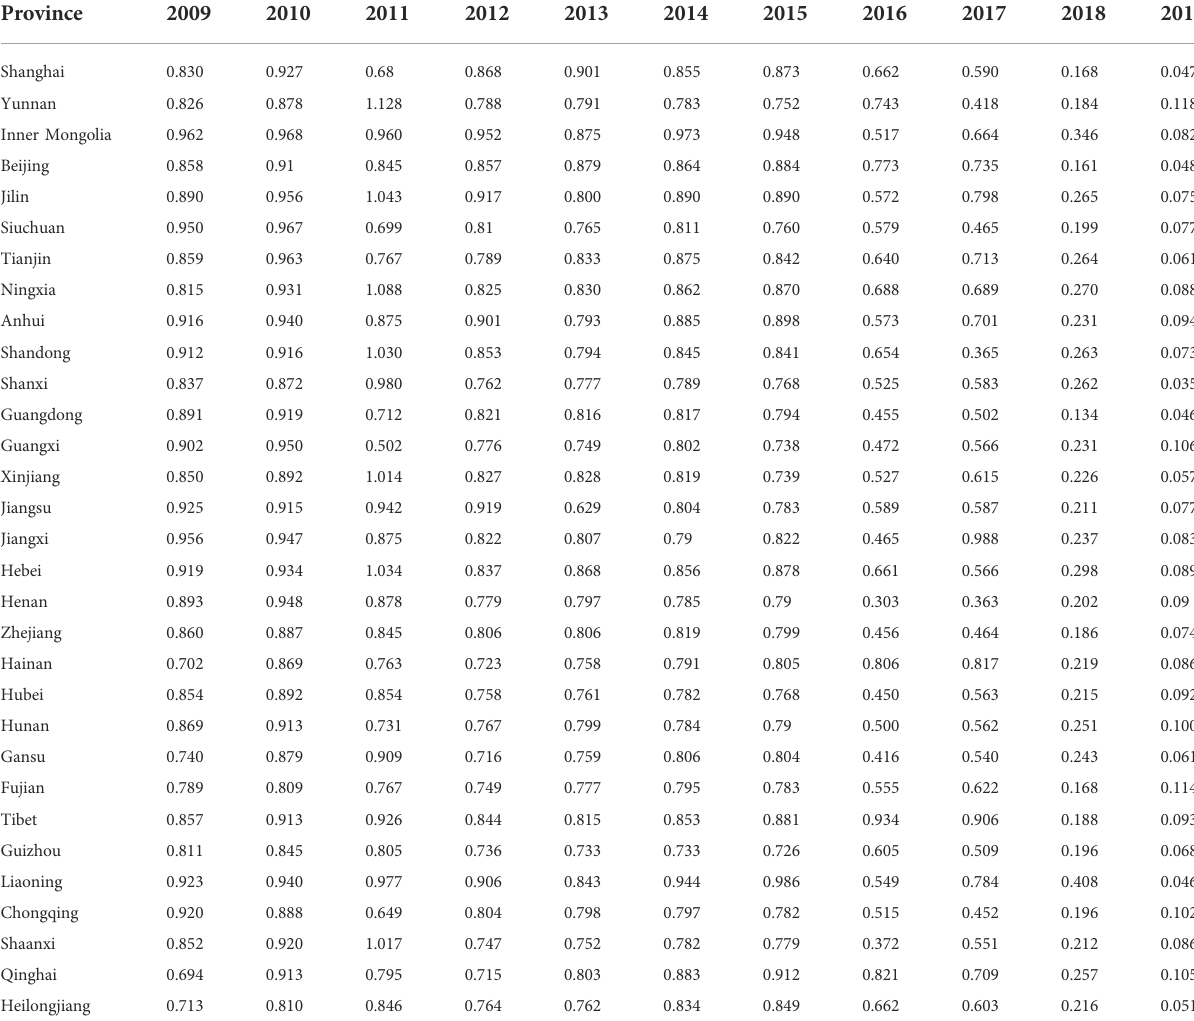
TABLE 2 Changes in green total factor productivity of the service industry.